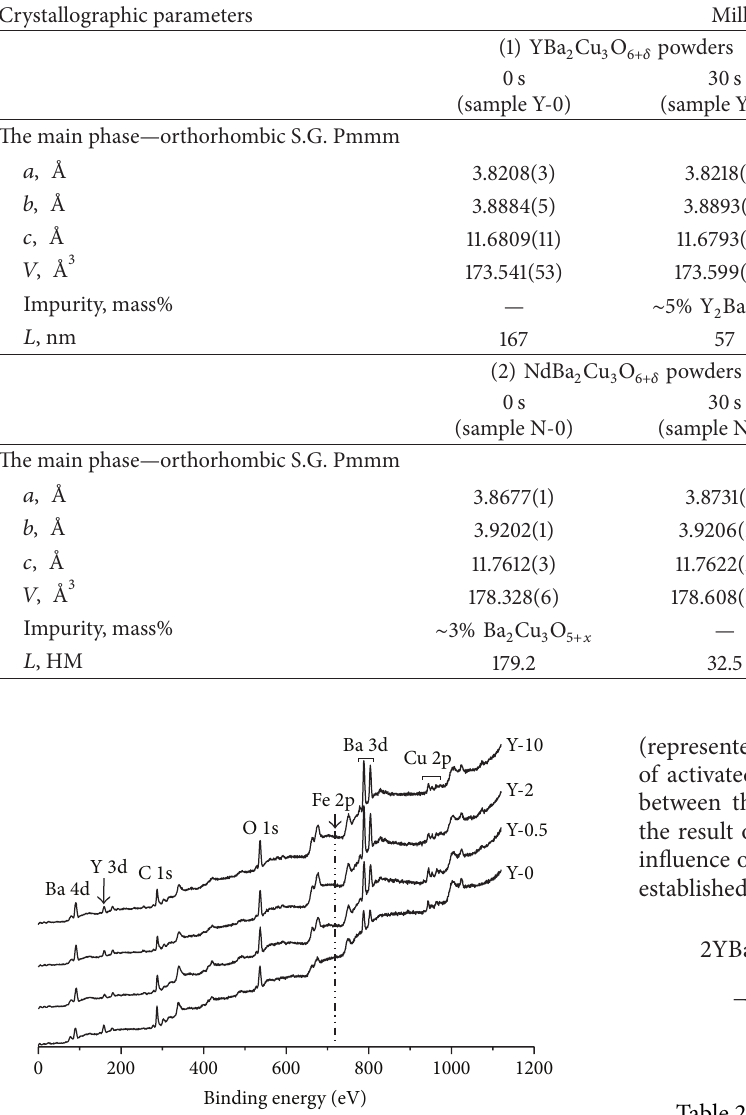
Figure 2: XPS survey spectra of the initial and mechanoactivated YBa 2 Cu 3 O 6+𝛿